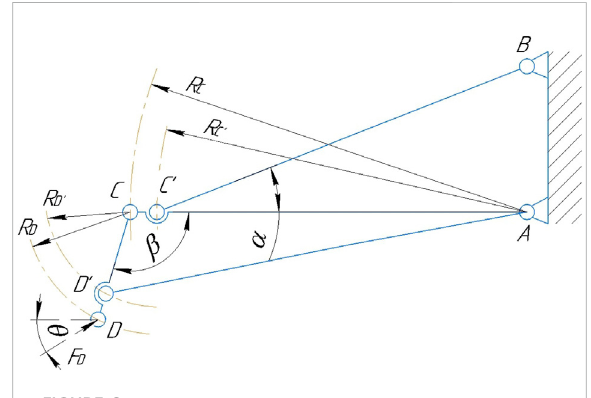
FIGURE 6 Design scheme of the suspension lever mechanism.